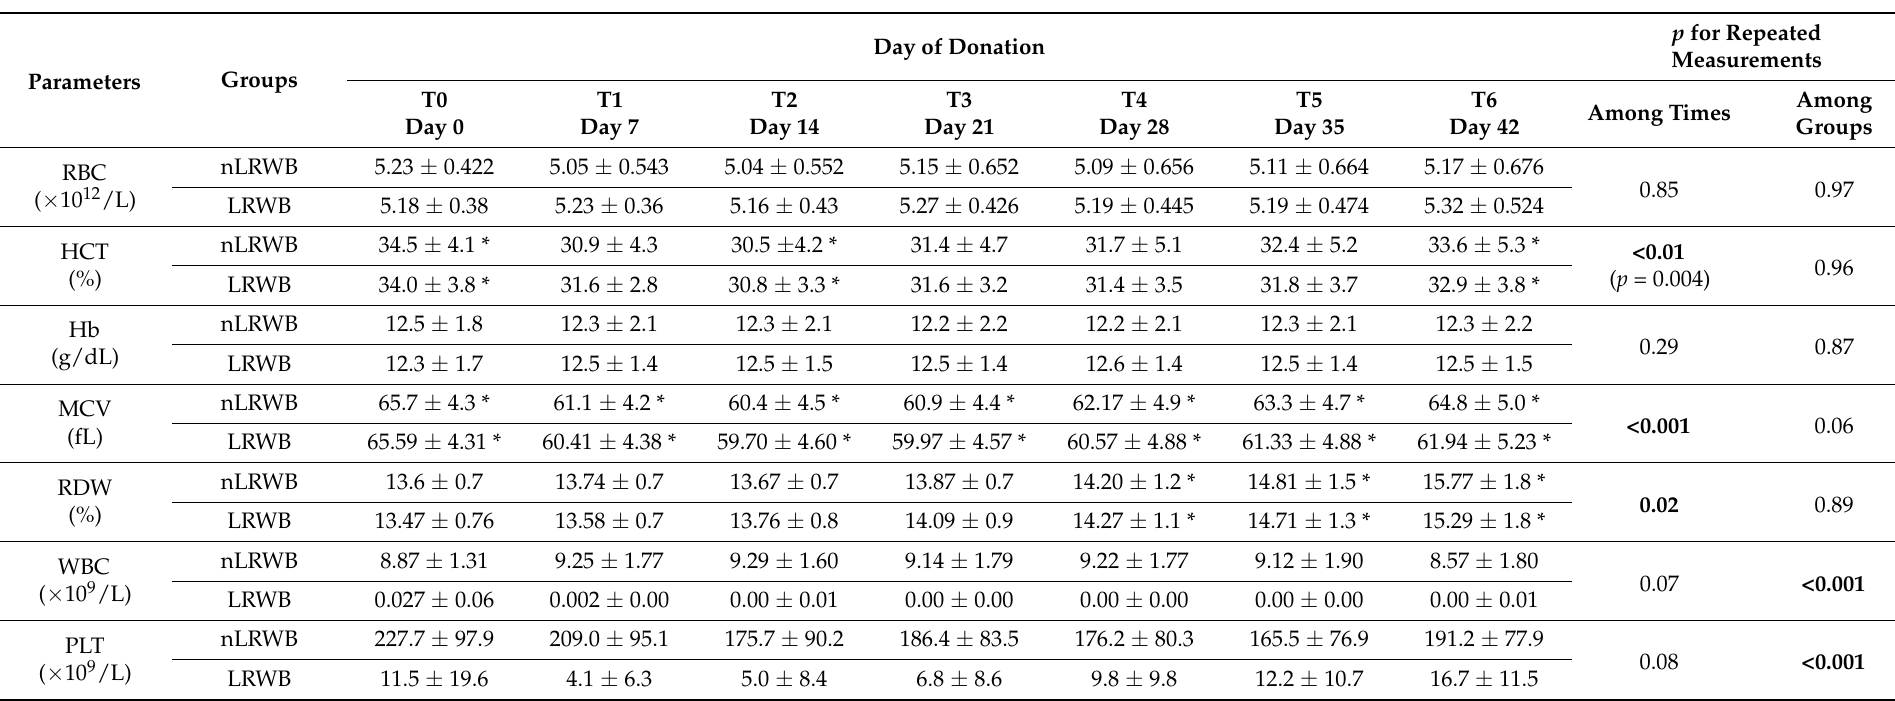
Table 1. Means ± standard deviations and significance of the parameters RBC( × 10 12 /L), HCT(%), Hgb(g/dL), MCV(fL), RDW(%), WBC( × 10 9 /L), PLT( × 10 9 /L) in nLRWB and LRWB groups, in the different days post-donation (T0 to T6). nLRW: not leukoreduced whole blood, LRWB: leukoreduced whole